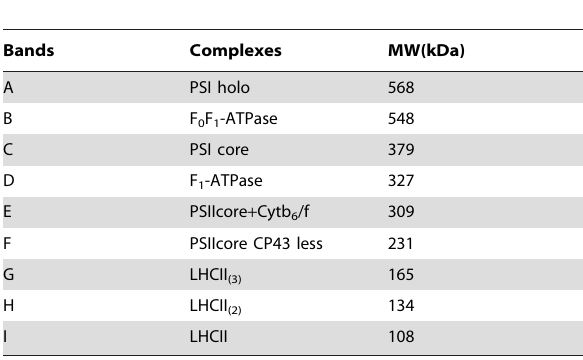
Table 1. Apparent MW of thylakoid membrane complexes from rice ( Oryza sativa